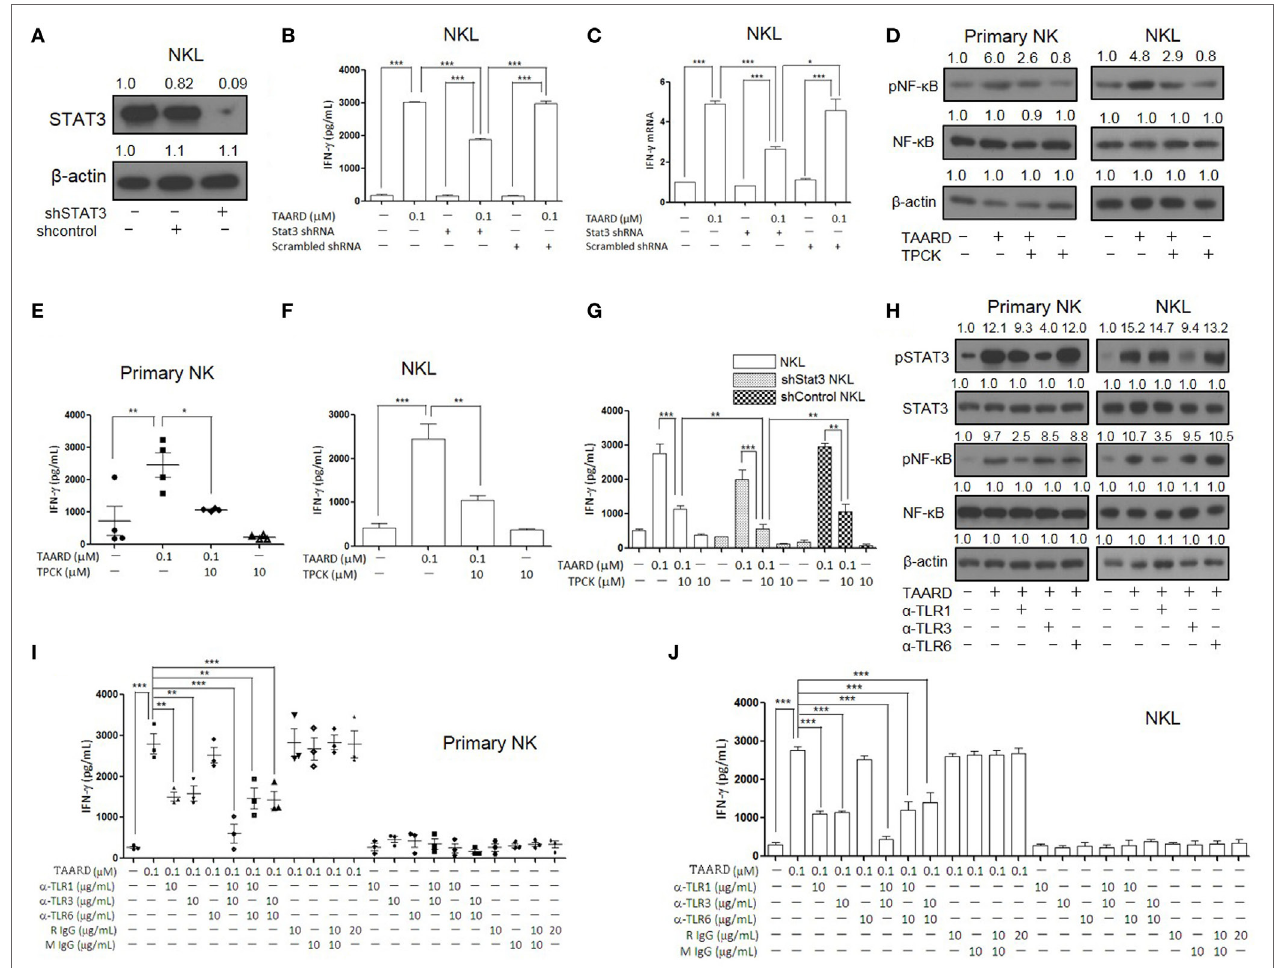
FigUre 5 | TAARD activates the TLR-1-NF- κ B and TLR3-STAT3 signaling pathways in natural killer (NK) cells. NKL cells were infected with concentrated lentivirus of pSIH1-puro-STAT3 shRNA or pSIH1-puro-control shRNA and selected with puromycin. The knockdown of NKL cells were treated with or without TAARD for 18 h. (a) STAT3 knockdown was confirmed by immunoblotting. (B) Cell-free supernatants were collected for analysis by enzyme-linked immunosorbent assay (ELISA). (c) Cell pellets were harvested for real-time RT-PCR. (D – F) Primary human NK cells and NKL cells were pretreated with the NF- κ B inhibitor tosyl- l - phenylalaninechloromethyl ketone (TPCK) (10 µM) and then exposed to TAARD for 18 h. NF- κ B phosphorylation inhibition was confirmed by immunoblotting (D) and the supernatants from primary NK (e) and NKL (F) cells were assayed for interferon (IFN)- γ secretion. (g) STAT3-knockdown NKL cells were pretreated